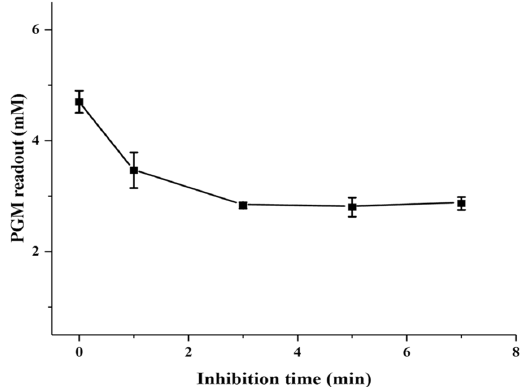
Figure 5. Effect of the inhibition time on the PGM readout. Conditions: α-glucosidase, 314.3 U/mL; incubation time, 5.0 min; AA-2G, 14.0 mM; inhibition time, 1.0–9.0 min; acarbose, 2.2